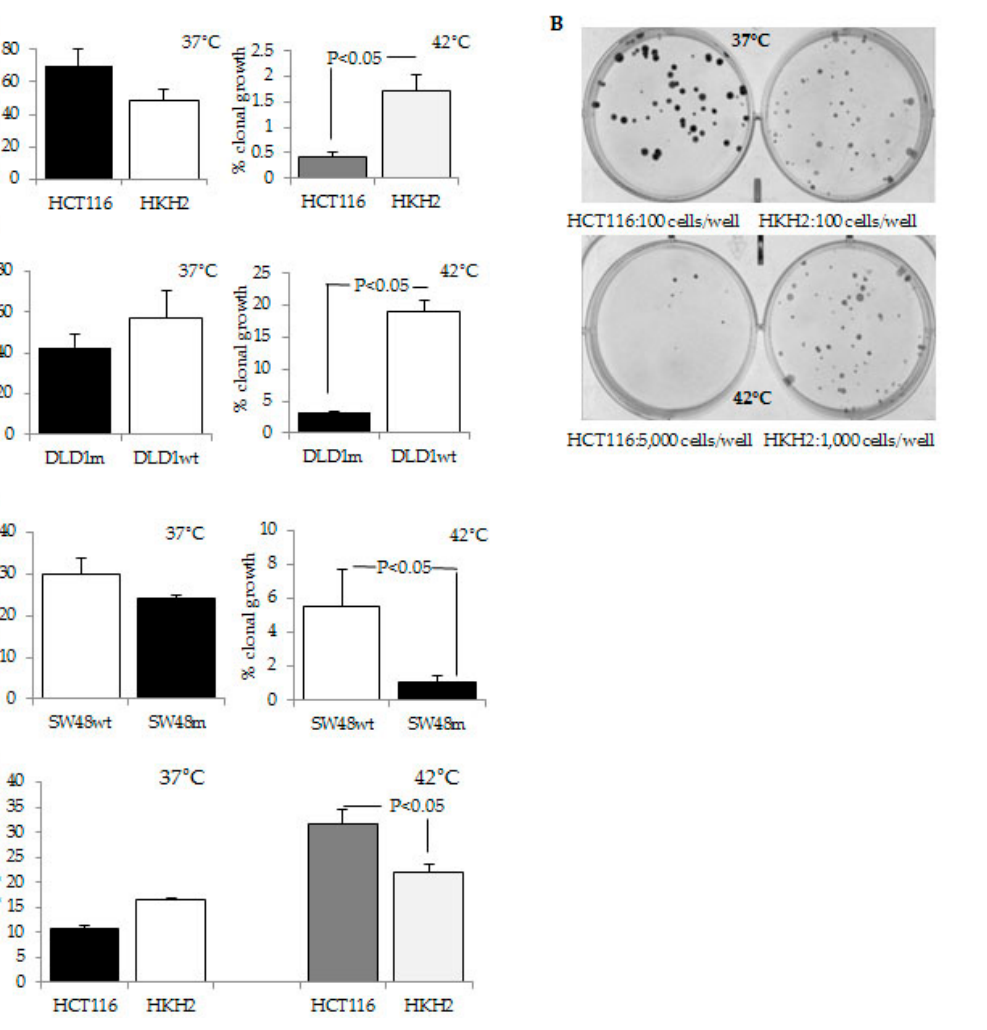
Figure 1. Differential hyperthermia response of mutant and wild type KRAS CRC cells. ( A ) Clonal growth assays. Cells were plated at 100 per well in six ‐ well plates and incubated at 37 °C for two weeks, or at 5000 cells/well (HCT ‐ 116) and 1,000 cells/well (HKH2), incubated at 42 °C for 24 h, and transferred to 37 °C for two weeks. The percent clonal growth is the ratio of number of colonies to number of all plated cells, multiplied by 100; ( B ) Representative results from clonal growth analyses described in (A); ( C ) Isogenic DLD ‐ 1m cells (with a mutant KRAS, G12D) and DLD ‐ 1wt (DLD ‐ 1 cells with a wild type KRAS ) were exposed to 37 °C or 42 °C for 24 h, and clonal growth was measured as described in (A); ( D ) Isogenic SW48wt cells (with a wild type KRAS ) and SW48m (with a KRAS mutation G12D) were assayed for clonal growth as described in (A). All clonal growth assays were performed with triplicate samples per treatment conditions; three to five assays were performed at each temperature; ( E ) Cells were exposed to 37 °C or 42 °C for 24 h. All cells (floating and attached) were harvested and stained for apoptotic and necrotic markers with R ‐ phycoerythrin (PE)––Annexin V Apoptosis Detection Kit I (BD Biosciences, San Jose, CA, USA). Four experiments with triplicate samples per treatment were performed.